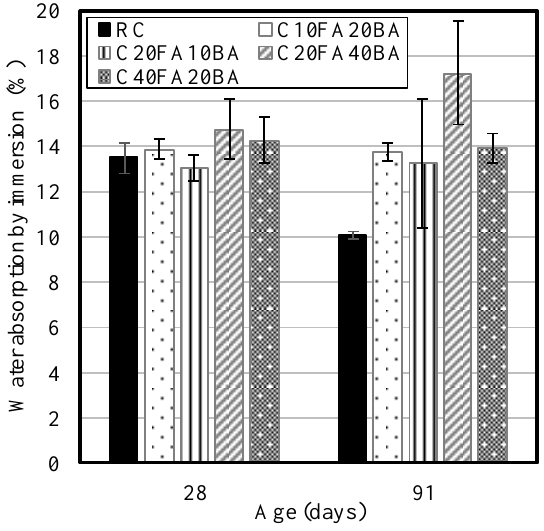
Figure 11. Water absorption by immersion at 28 and 91 days.